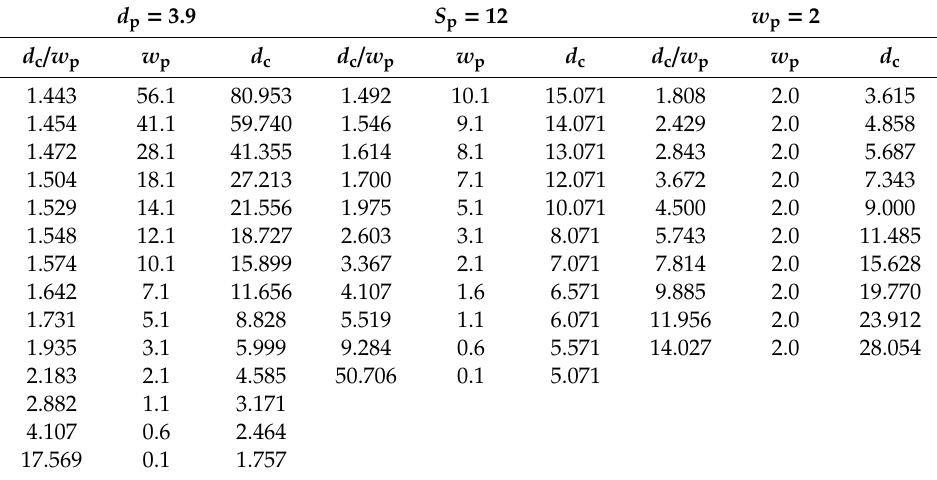
Table 3. Values of d c / w p ratio and corresponding passage width w p and diameter of the interstitial volume d c for post arrays of di ff erent geometry modifications defined in the text, the length dimensions are in the simulation units; 1 unit ≈ 2.5